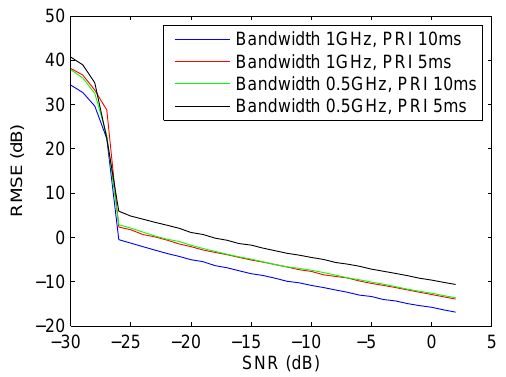
Figure 5. The performances of the proposed CCAE method with different